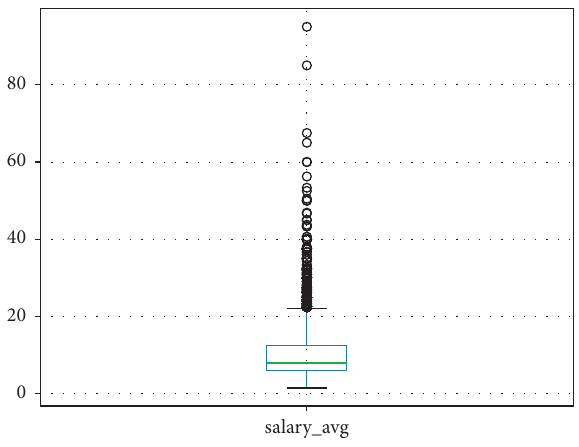
Figure 4: Average employee salary. Figure 5: Enterprise human resource